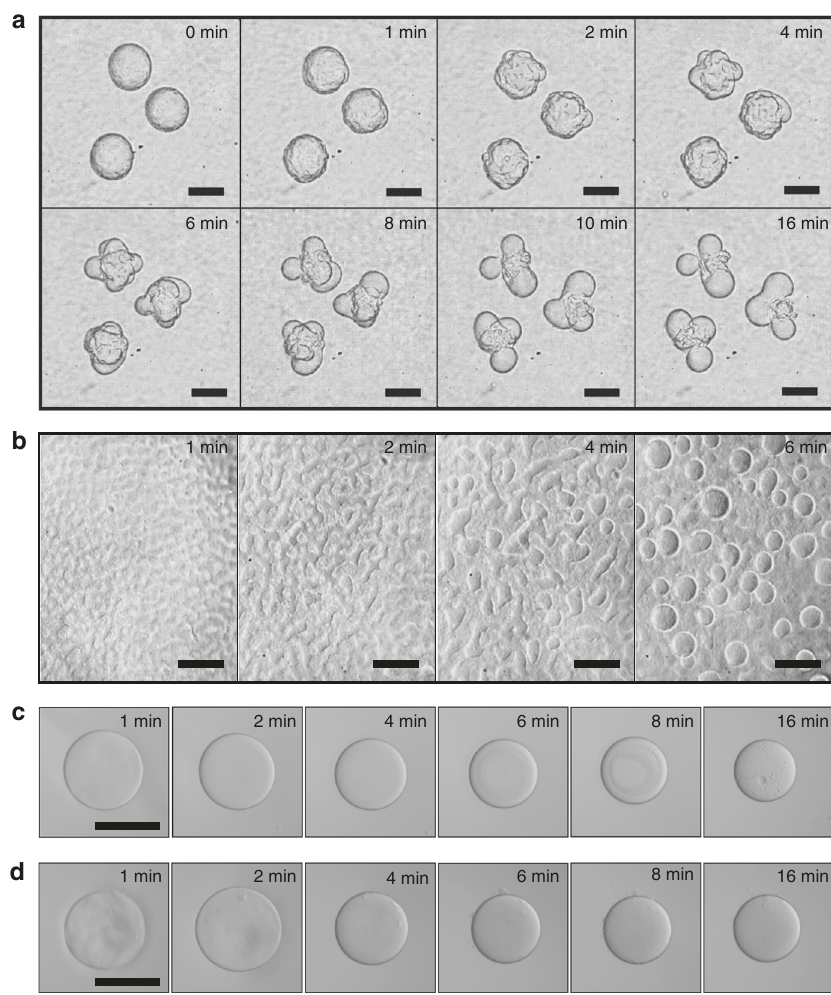
Fig. 1 Budding-like division of w/w droplets loaded with protein nano fi brils. a Optical microscope images of dividing w/w emulsion droplets preloaded with protein nano fi brils. The droplet phase was preloaded with 7.5 wt% dextran T500 and 1.2 wt% lysozyme nano fi brils before injection into a 8 wt% PEG-10 mM HCl solution. b Optical microscope images showing the formation of protrusions on a fl at w/w interface. No splitting of w/w droplets was observed when the concentration of fi brils was c 0 wt% and d 0.1 wt%. Scale bars are 200 μ